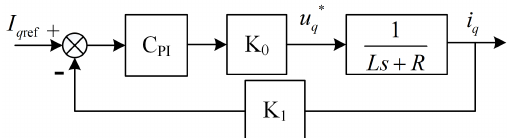
Figure 12. The simplified PMSM current control